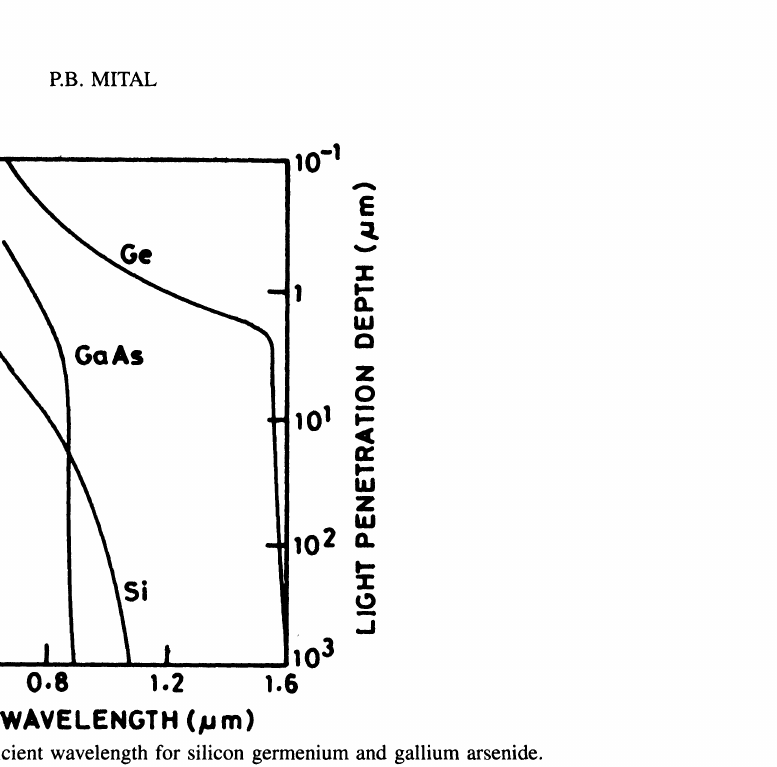
WAVELENGTH (pm) FIGURE A Optical absorption coefficient wavelength for silicon germenium and gallium